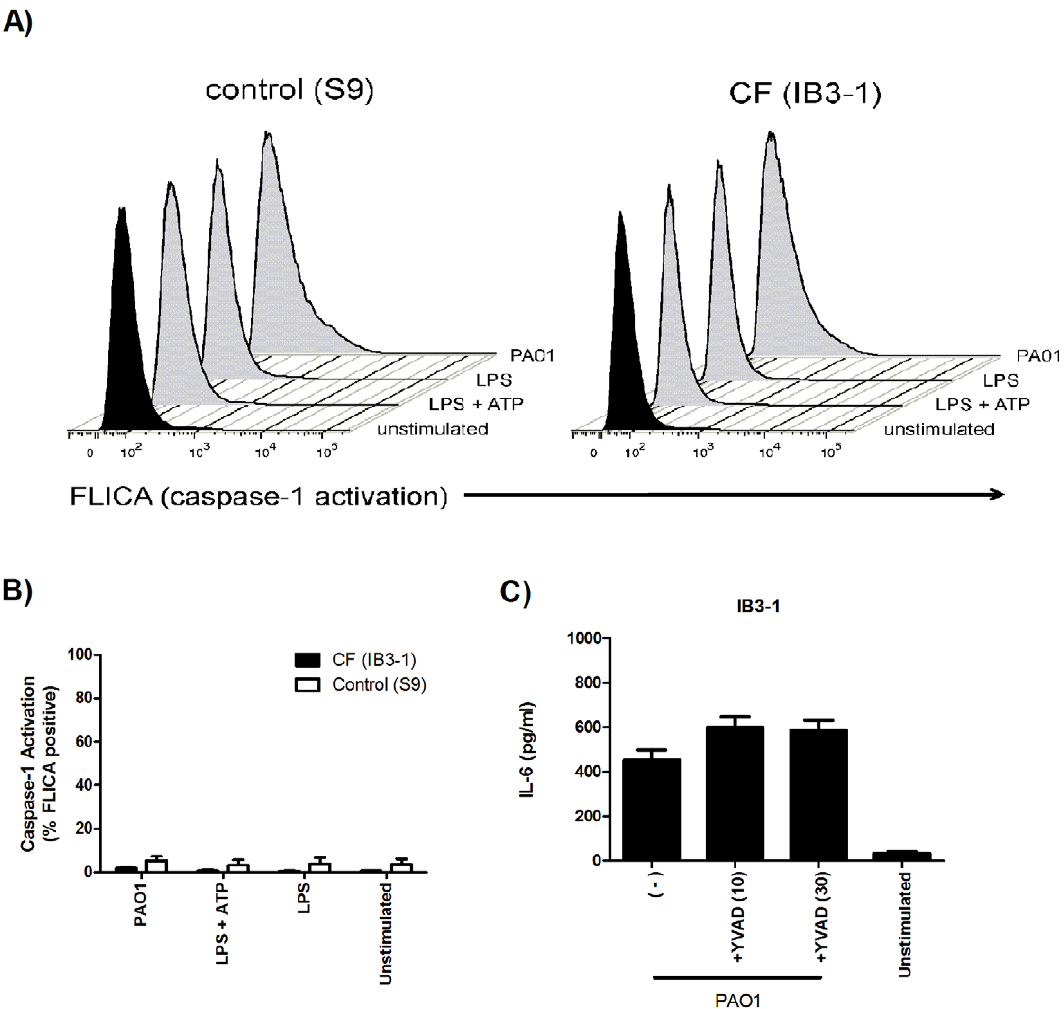
Figure 3. Airway cells do not strongly upregulate caspase-1 activity in response to inflammasome stimuli. S9 and IB3-1 cells were examined for caspase-1 activation following inflammasome stimulation with P. aeruginosa (MOI=10) and ATP (5 mM). Cells were primed with LPS for 5 hours where appropriate. A representative histogram of % caspase-1-active cells is shown in (A) and the averaged values are shown in (B) (n=3 separate experiments). (C) IB3-1 cells (5 6 10 4 cells/well) were pre-treated for 1 hour with increasing concentrations of z-YVAD-fmk (10–30 m M) prior to stimulation with P. aeruginosa (MOI=50). Cell culture supernatants were collected after 6 hours and assayed for IL-6 by ELISA (n=3).